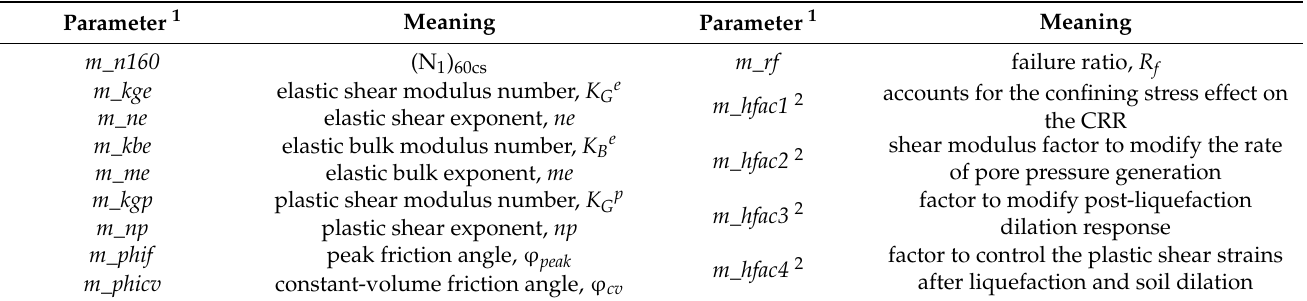
Table 2. Input parameters of the UBCSAND model in FLAC.